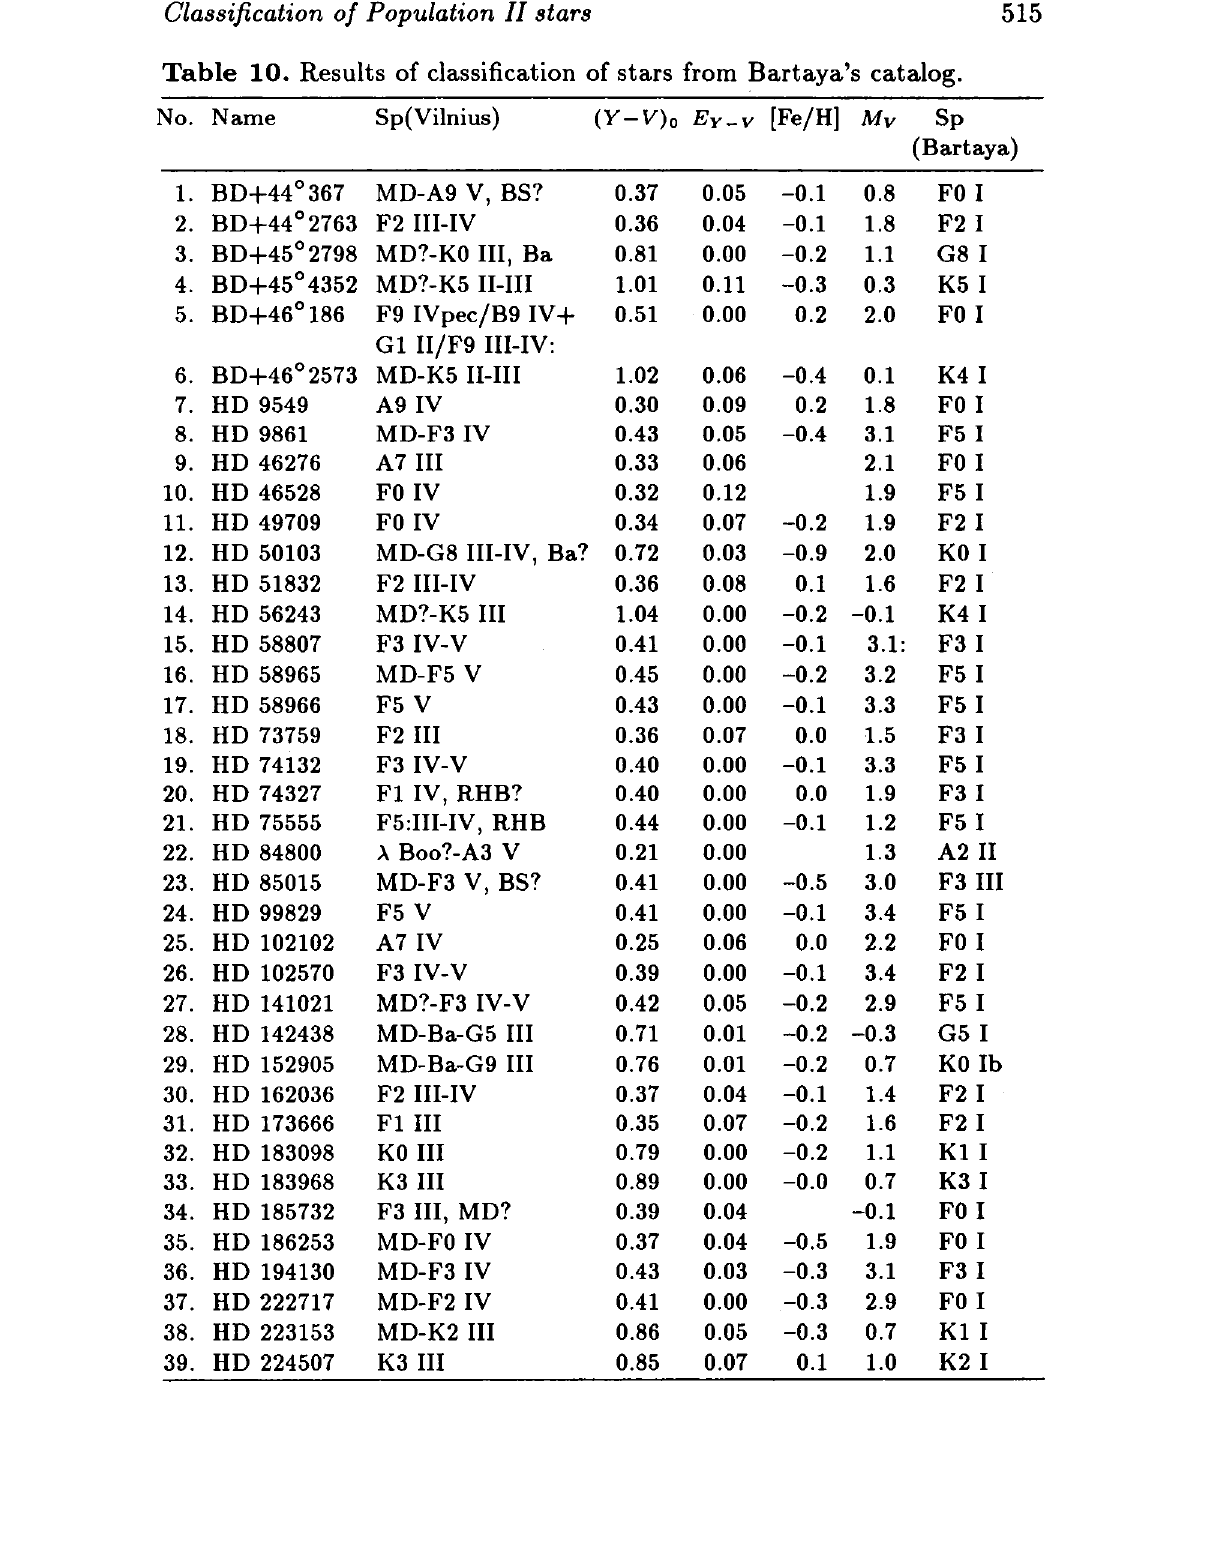
Table 10. Results of classification of stars from Bartaya's